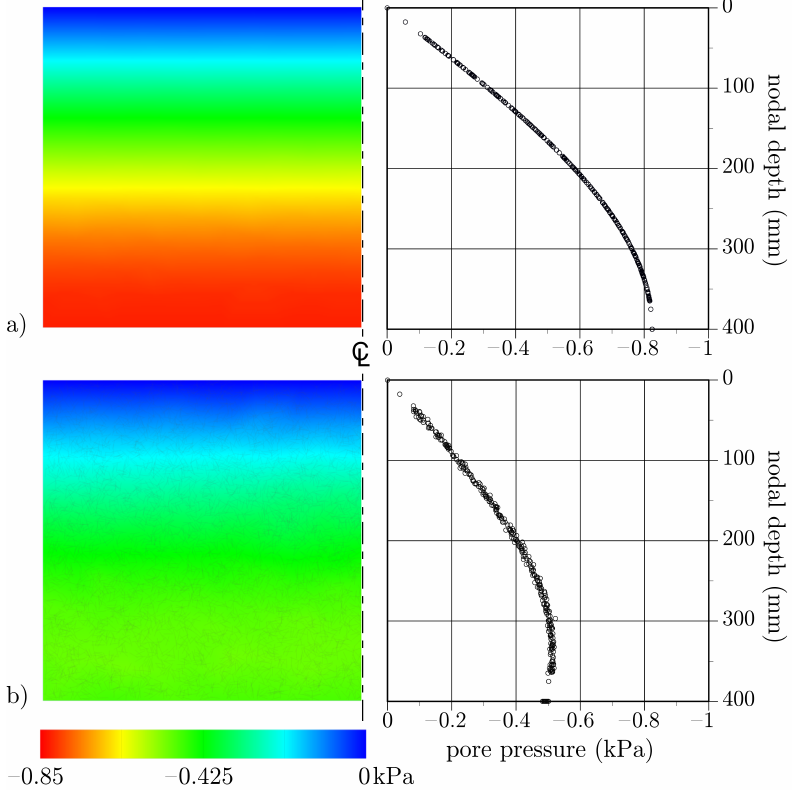
Figure 18. Pore pressure distribution and nodal value profile at t = 90 min for: ( a ) V f = 0%; and ( b ) V f =